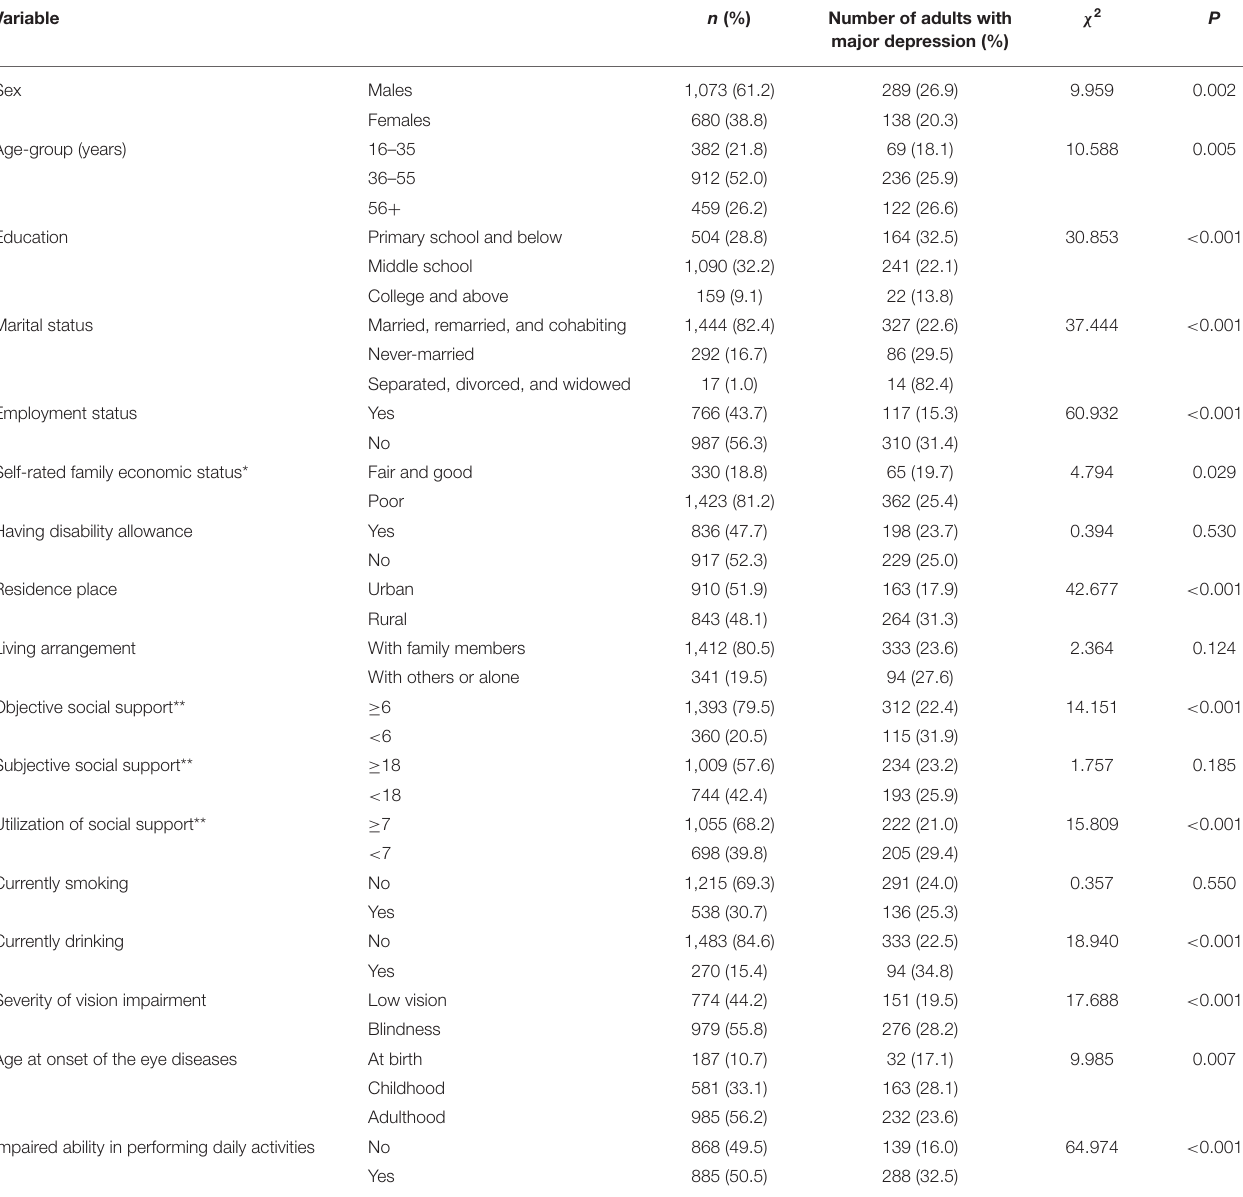
TABLE 1 | Characteristics of participants and prevalence rates of major depressive disorder by demographic, lifestyle, and clinical factors. Variable n